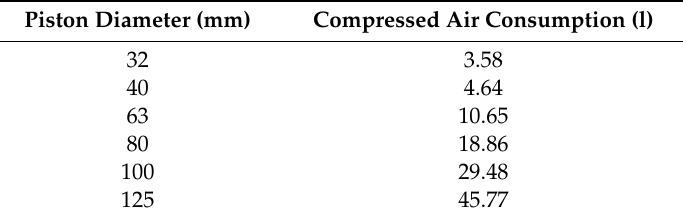
Table 1. Air consumption results for the system in Figure